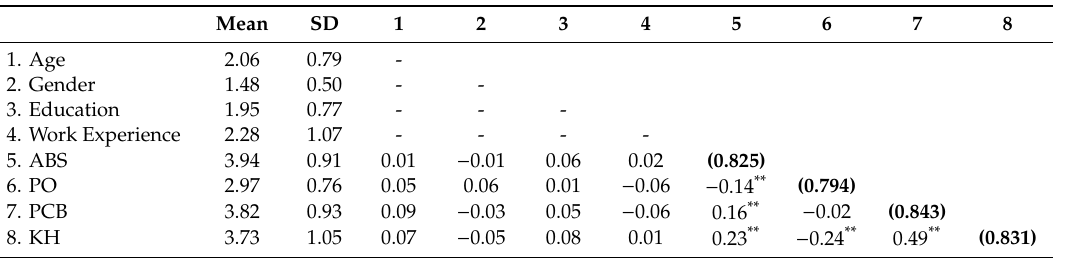
Table 3. Descriptive results.